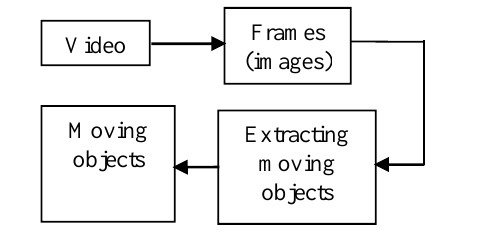
Figure 3: The process of the detecting moving object step.